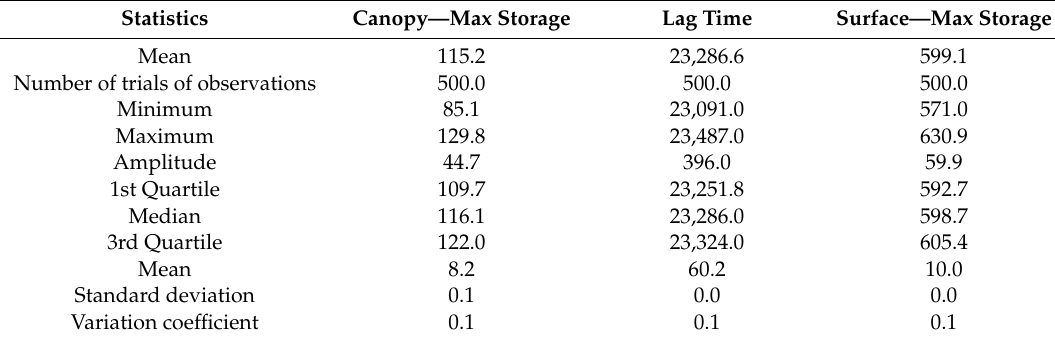
Table 9. Results of Monte Carlo Analysis with 500 Trials.